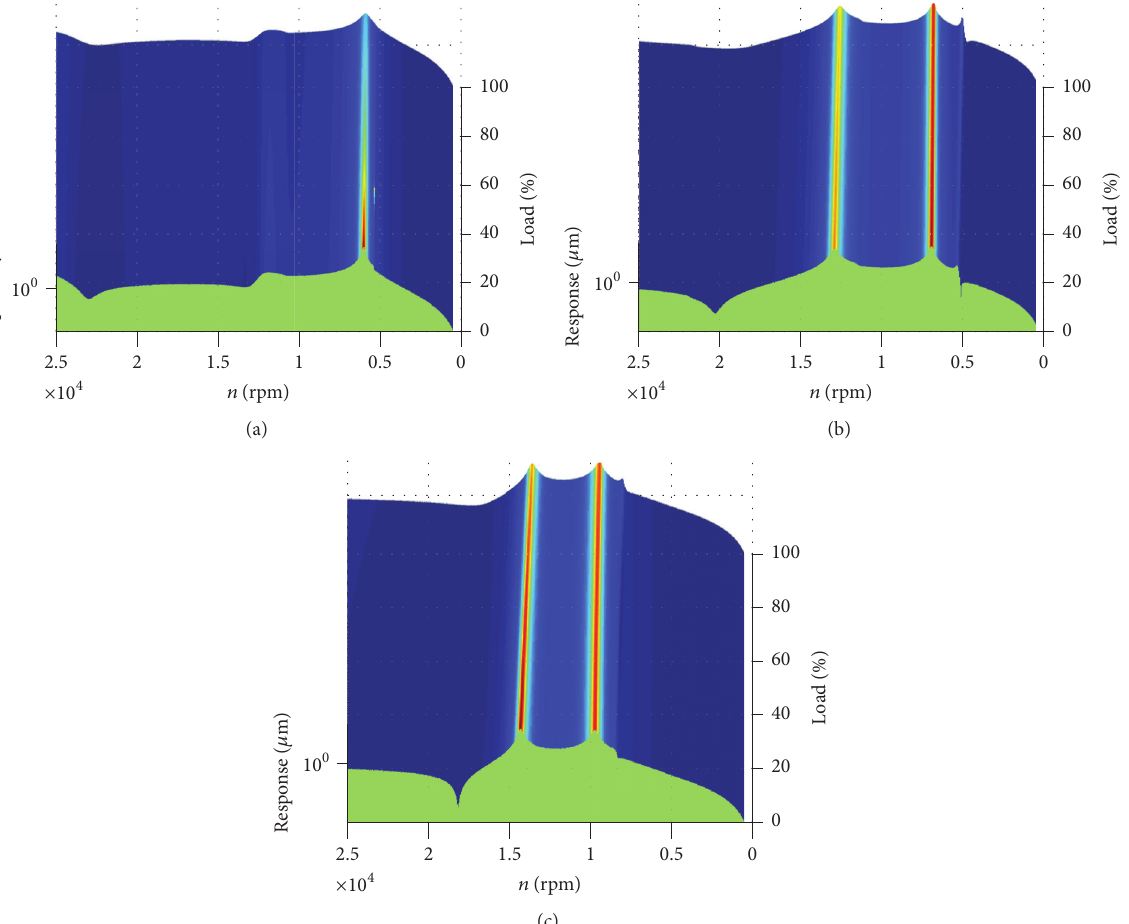
Figure 12: Unbalance response of three output shafts only considering axial torque and axial force under varying workload, (a) output shaft 1; (b) output shaft 2; (c) output shaft 3.